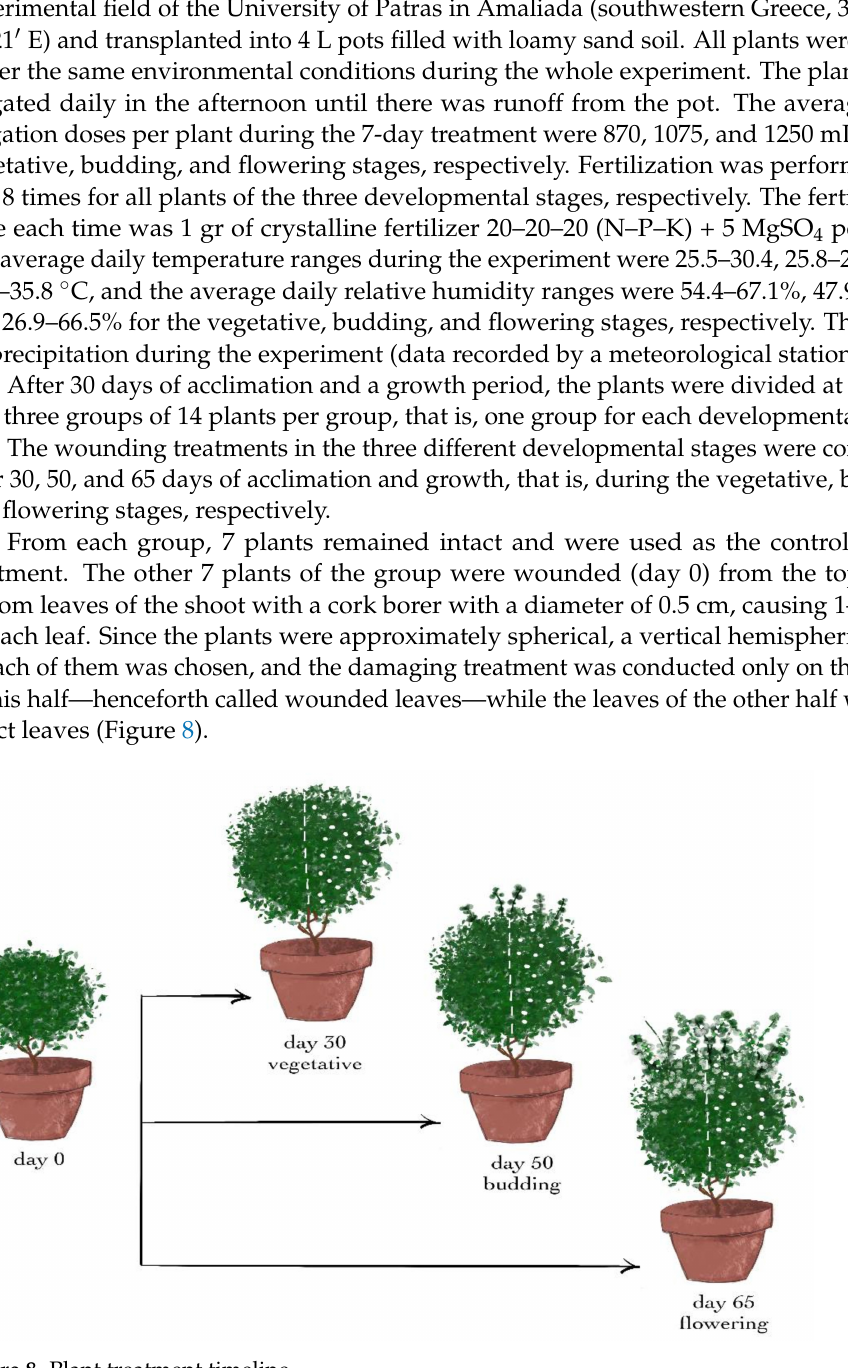
Figure 8. Plant treatment